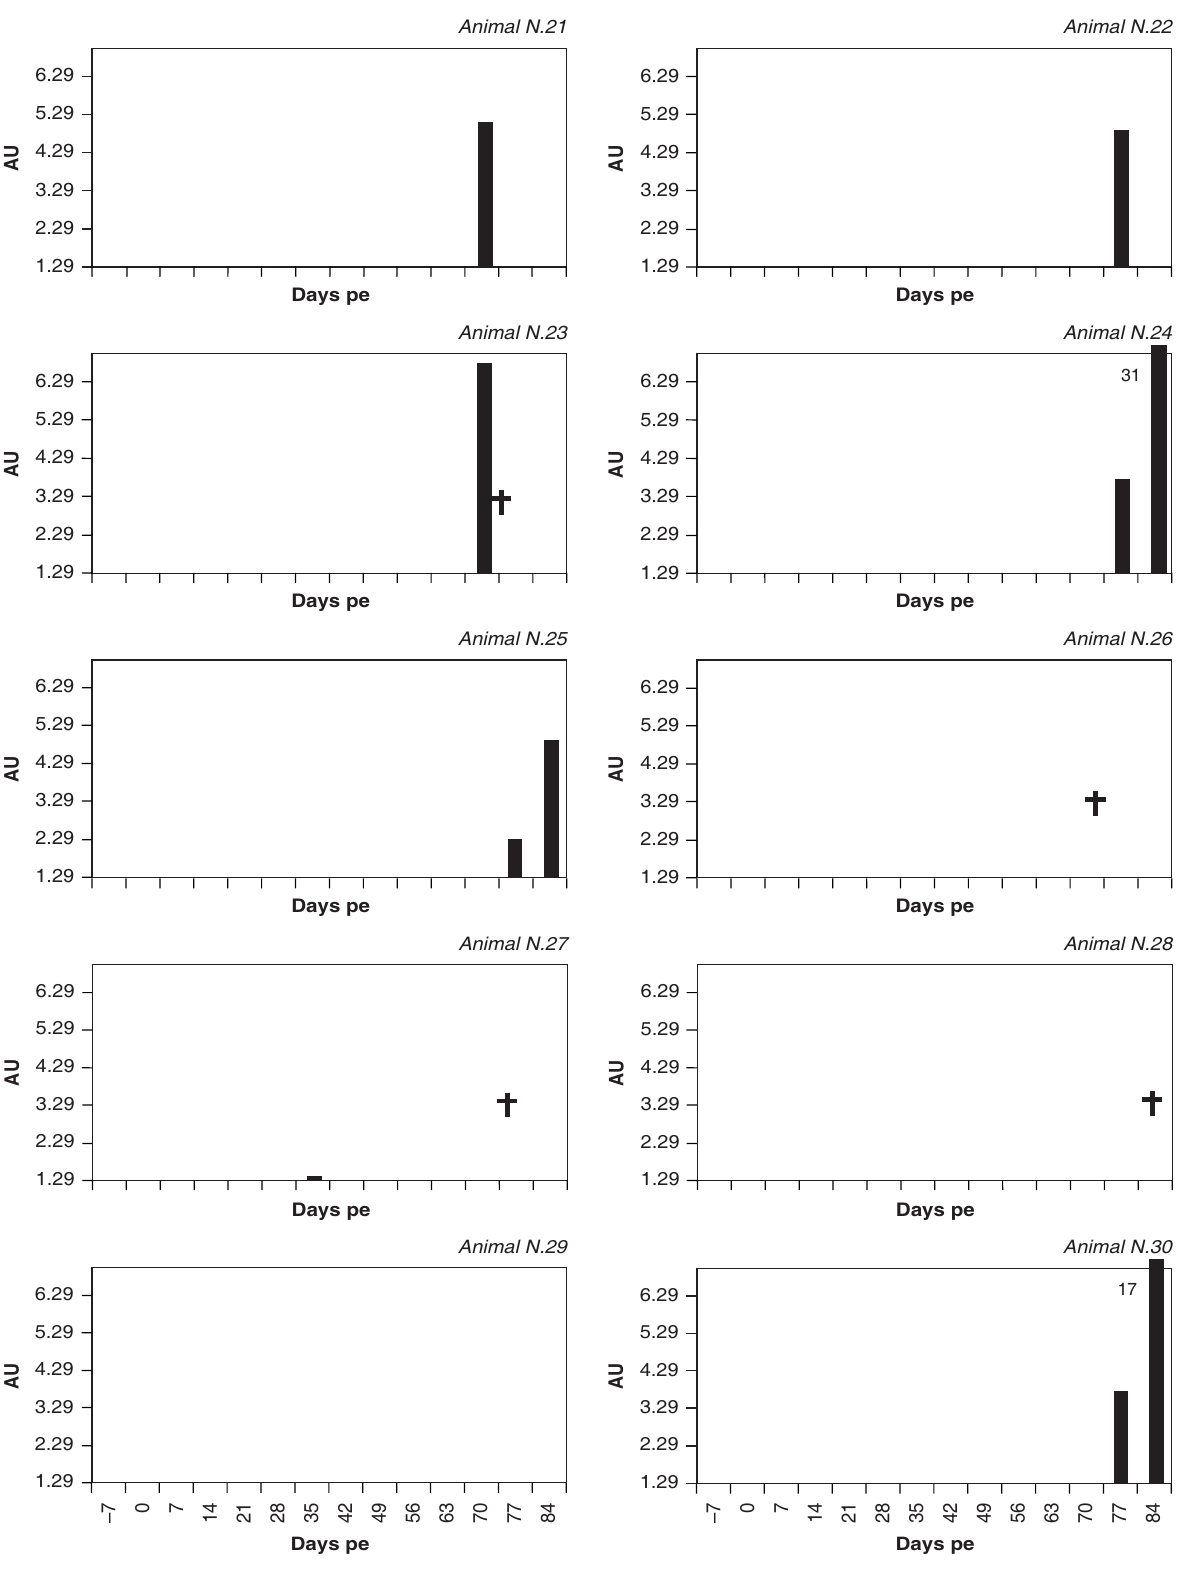
FIG. 2 IFN γ release by lymphocytes stimulated with Mmm SC in cattle infected by contact and treated with CsA. Lymphocytes iso- lated from blood were cultured with Mmm SC and incubated for 24 h. IFN γ from supernatant was measured using the